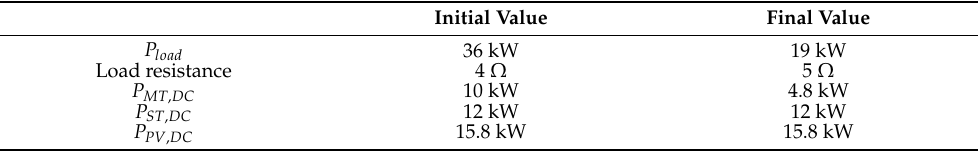
Table 11. Power production variation to achieve the objective.